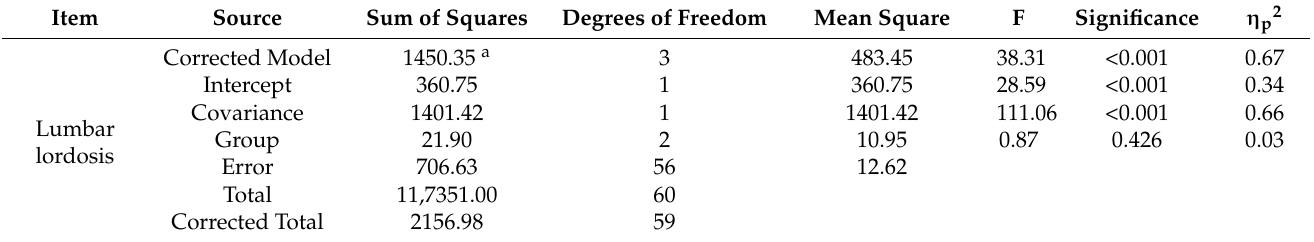
Table 8. Analysis of covariance results for lumbar lordosis.